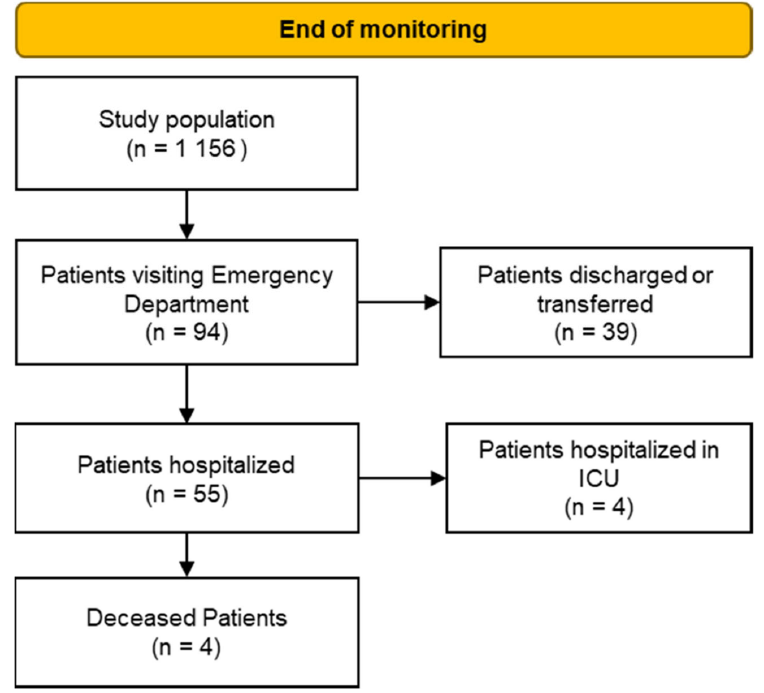
Figure 9. Study patients who accessed the ED.